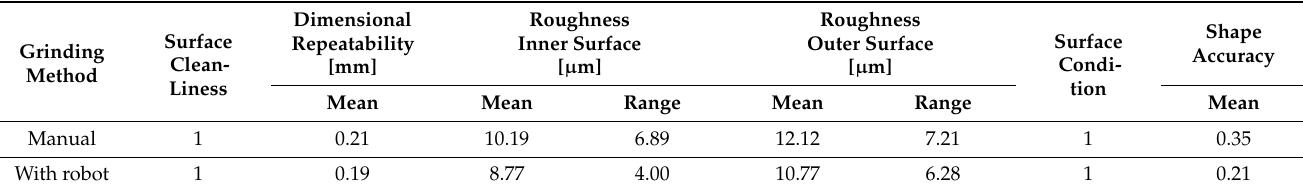
Table 7. The results of manual and robotic belt